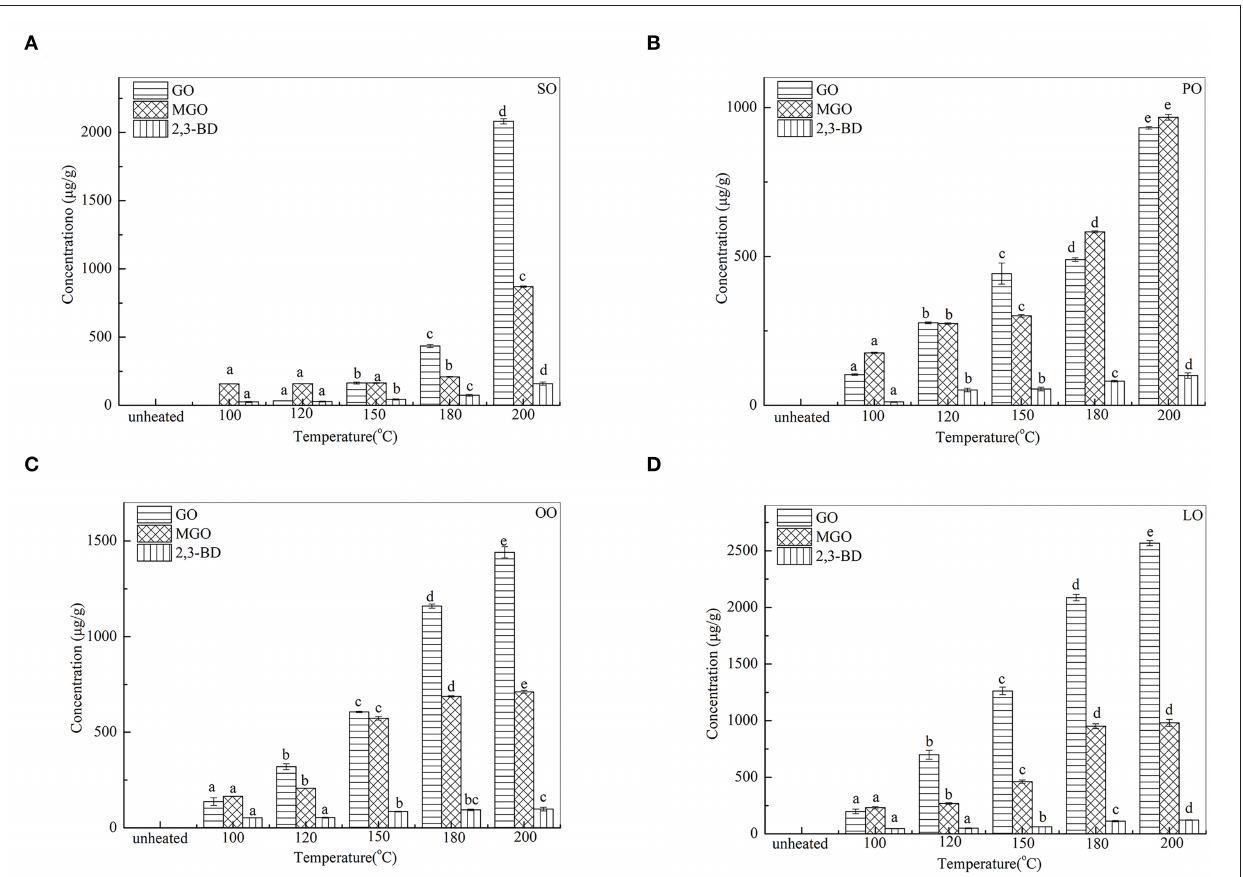
FIGURE 1 | Changes of a-DCs in SO (A) , PO (B) , OO (C) , and LO (D) at different temperatures. Data were expressed as mean ± SD in triplicates. Different lowercase denotes significant difference ( p < 0.05).